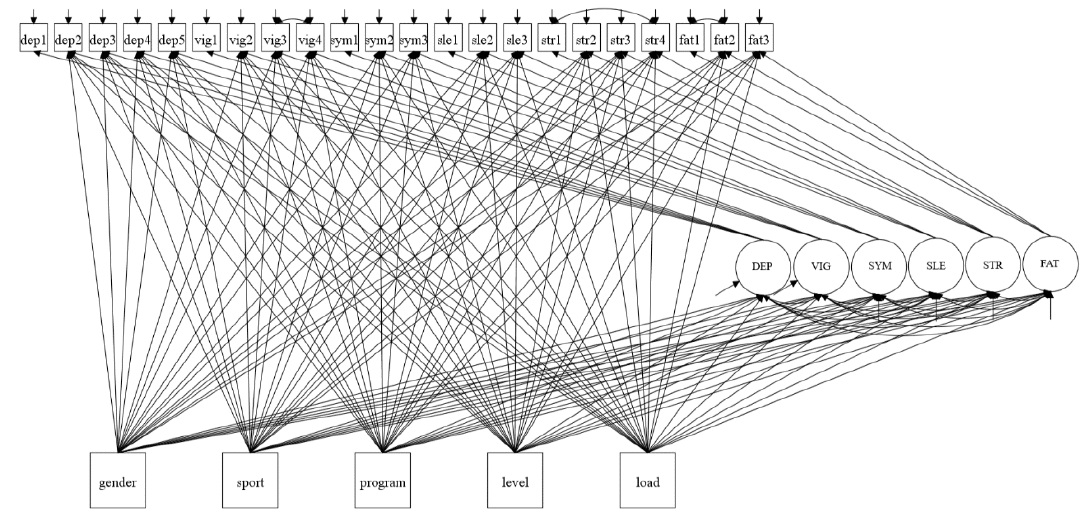
Figure 4. MIMIC model testing for differential item functioning (DIF). The five covariates affect all the six factors and all the items except one of each latent variable.